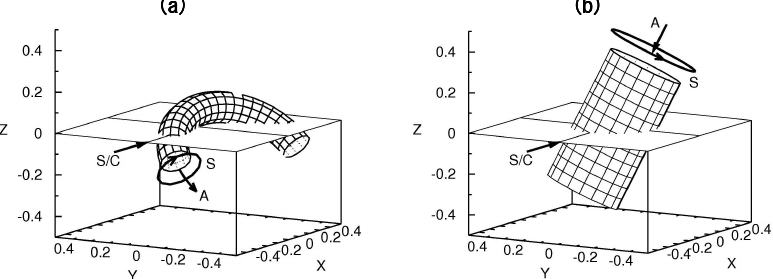
Fig. 5. Two geometries obtained for the magnetic cloud of 19 March 2001 (Event 13), from the fittings to the torus model (a) and to the cylinder model (b) . Note that the result from the cylinder model is not very successful (see Fig. 4 and